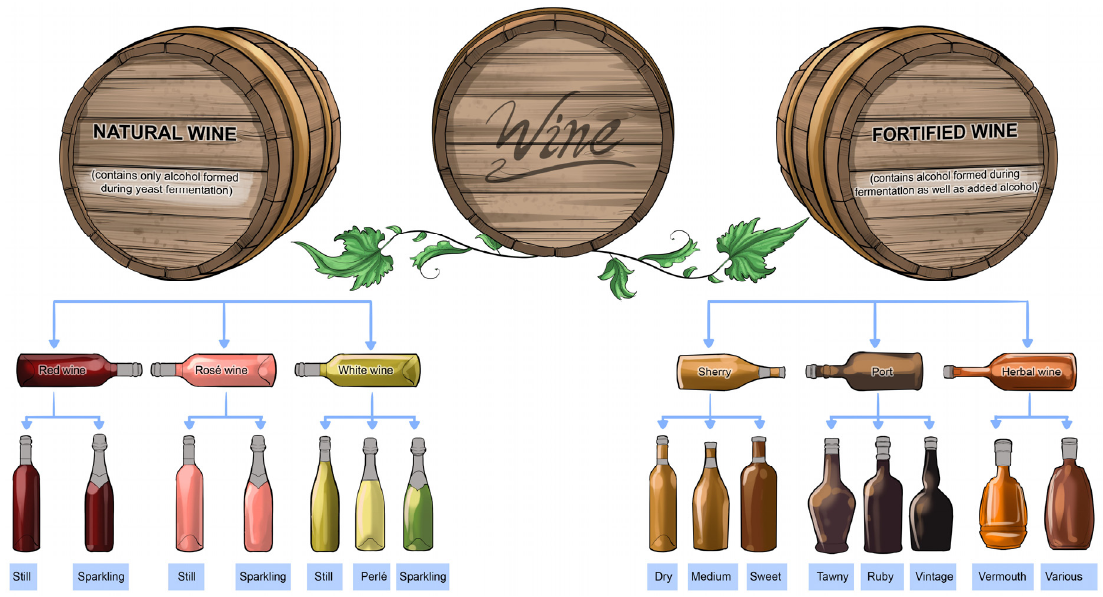
Figure 6. The general range of wine types (adapted from [9]). ‘Natural’ wine generally refers to a type of wine that contains alcohol that formed during yeast fermentation while ‘fortified’ wine refers to wine types that contain alcohol that formed during yeast fermentation as well as added alcohol. The category of ‘natural’ wine includes red, rosé and white wine that can either be ‘still’ or ‘sparkling’. ‘Fortified’ wine types include sherry, port and several formats of herbal wine, such as vermouth.